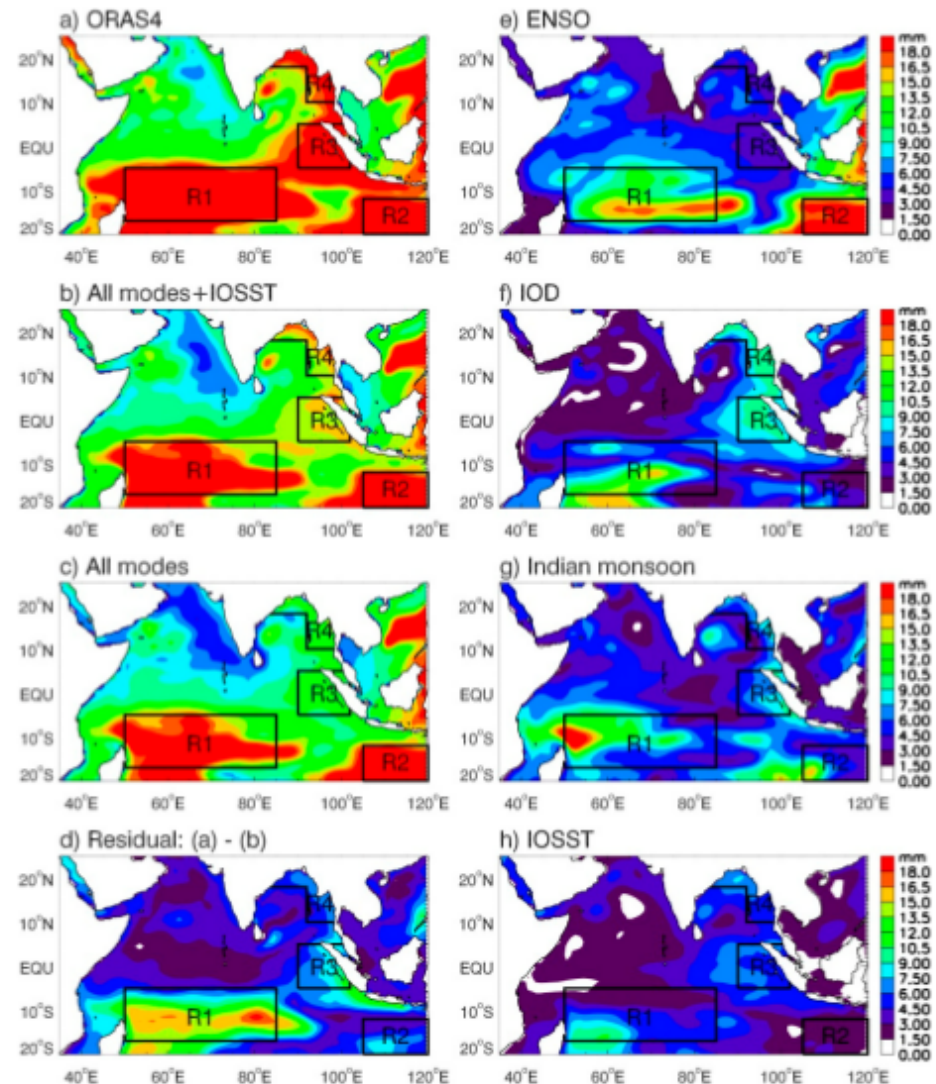
Figure 8. ( a ) The standard deviation map of the ORAS4 8 year low-passed SLA for the 1962–2011 period of the northern hemisphere summer season, based on the May–October averaged data of each year; ( b ) same as ( a ) but for SLA associated with all climate modes (ENSO + IOD + monsoon) plus the effect of IOSST which, to some extent, represents external forcing; ( c ) same as ( b ) but only for climate modes (ENSO + IOD + monsoon) and it equals the IOSST effect subtracted from panel ( b ); ( d ) same as ( b ) but for the residual, difference for ( a , b ), measuring the effects that cannot be explained by the climate modes and IOSST; ( e – h ) are the same as ( b ) but for the individual effect of decadal ENSO, IOD, monsoon, and IOSST. Units: mm. The figure is the same as Figure 6 except for the northern